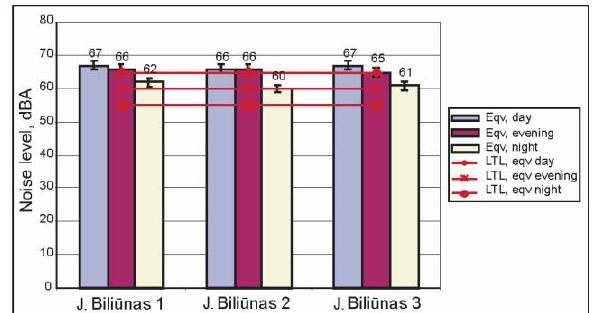
Fig. 20. Dynamics of equivalent noise levels in J. Biliūnas street within twenty four hours